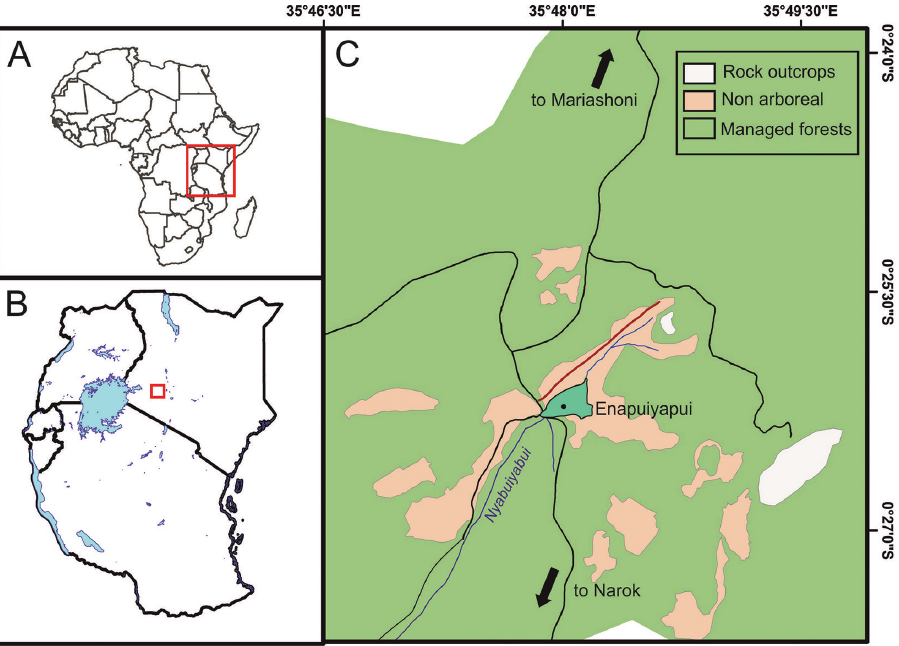
Figure 1. Location of the study site in Africa ( A ) and within Kenya ( B ). The location of the coring site (black circle) within Enapuiyapui ( C ). The red line represents a fire break